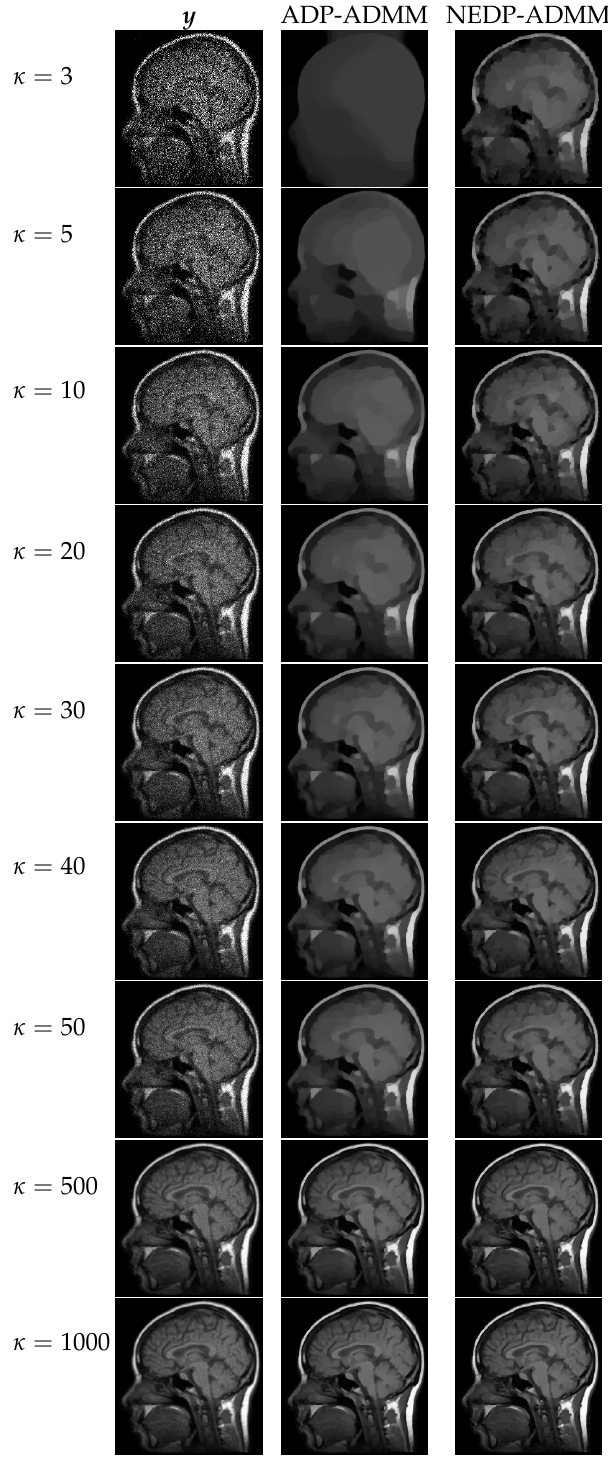
Figure 10. Test image brain . Left column: observed data y corrupted by Gaussian blur with parameters band = 5, sigma = 1 and Poisson noise with different κ -values ranging from 3 to 1000. Middle column: restorations by ADP-ADMM. Right column: restorations by